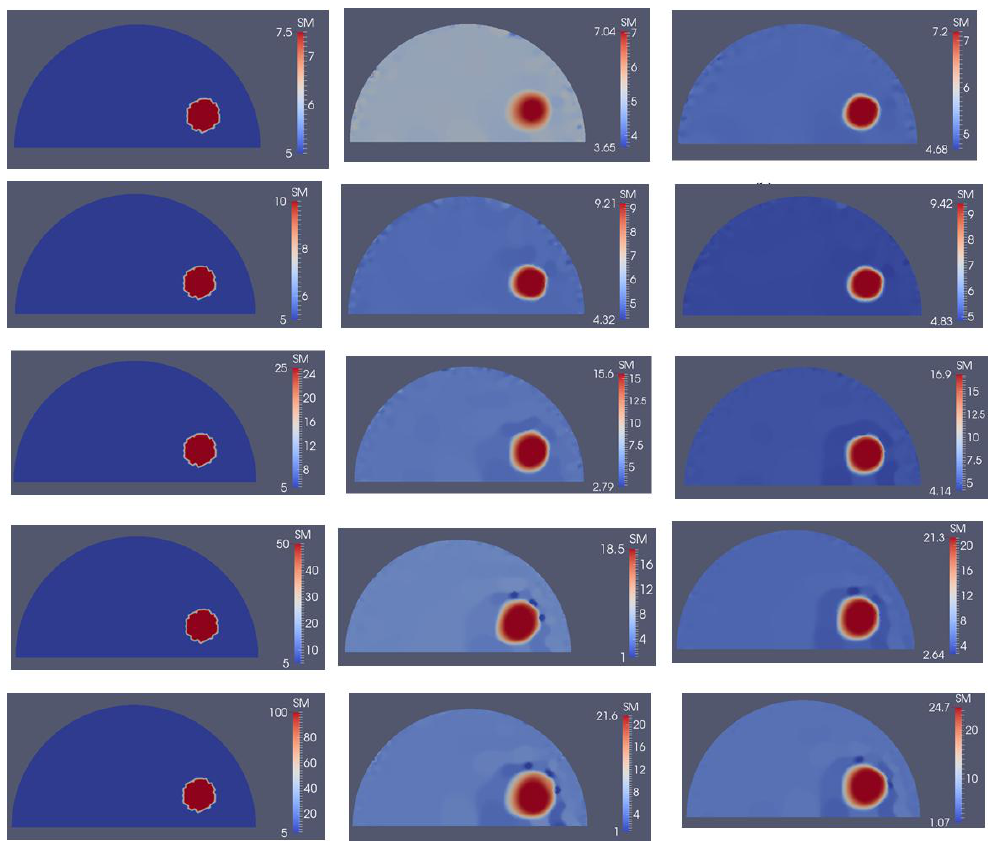
Figure 14. Problem domain with target shear modulus distribution is defined in the first column with varying shear modulus values in the inclusion from 7.5 (top row) to 100 kPa (bottom row) to test the feasibility range of stiffness detection. Columns 2 and 3 represent the shear modulus reconstructions with 5 and 10 boundary displacement data sets, respectively, using 0.1% noise.